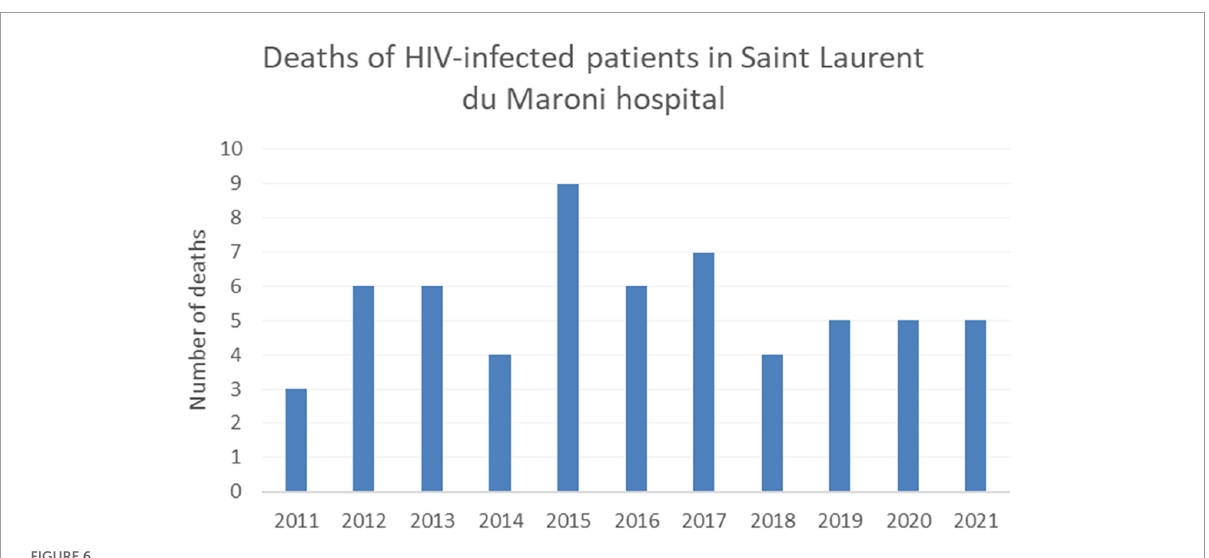
FIGURE6 Evolution of the number of HIV-related deaths in Saint Laurent du